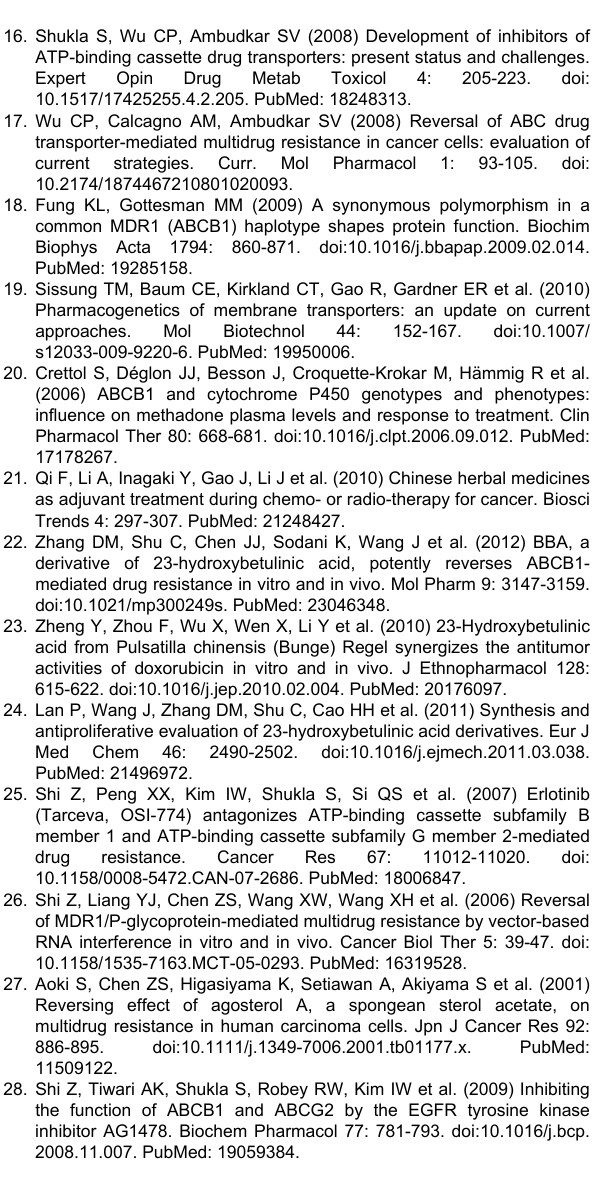
Figure S1. The survival curves of HEK293/pcDNA3.1 and HEK293/MRP7 at different concentrations of BBA.